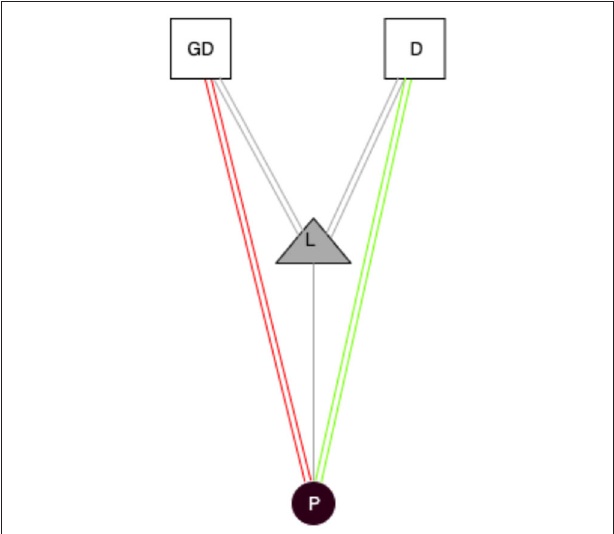
FIGURE 8 | Emotional attachment of socio-material network of Patrizio. Circle, actors (P, Patrizio); Triangle, analog objects (C, Computer); Squares, digital objects (GD, Google Docs; D, Dropbox); Gray lines, usage of analog objects; Red double lines, not positive emotional attachment of usage of digital objects; Green double lines, positive emotional attachment of usage of digital objects; Gray double lines, analog/digital